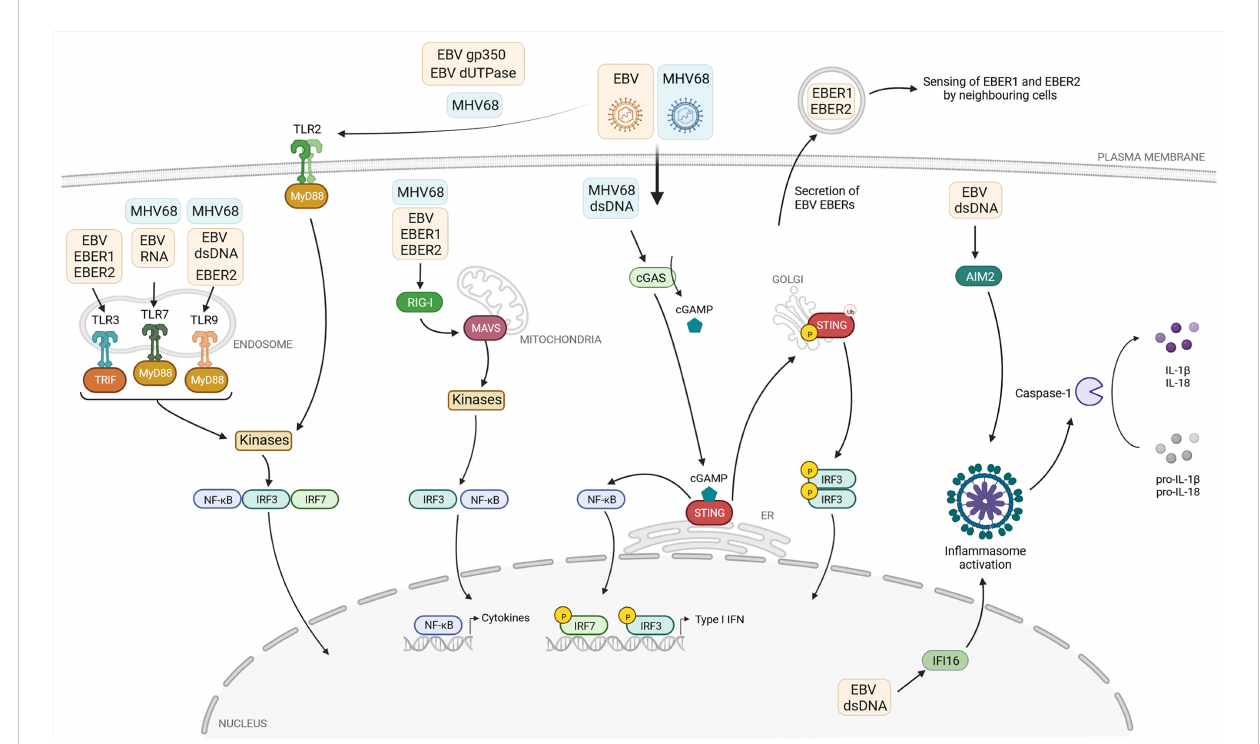
FIGURE 1 Current knowledge about the detection of the gammaherpesviruses EBV and MHV68 by pattern recognition receptors. The pattern recognition receptors (PRR) Toll-like receptors (TLR) 2, 3, 7, and 9, the cytoplasmic RNA sensor retinoic-acid-inducible protein 1 (RIG-I), and the DNA sensor cyclic GMP-AMP (cGAMP) synthase (cGAS) sense viral proteins or viral nucleic acids associated with EBV (yellow box) or MHV68 (blue box). If known, the viral ligands are depicted in the respective boxes. After binding their ligands, these PRR initiate a signaling cascade, leading to recruitment and/or activation of adaptor molecules: TIR domain-containing adaptor-inducing interferon- b (TRIF) and myeloid differentiation primary-response protein 88 (MyD88) in the case of TLRs, mitochondrial antiviral signaling protein (MAVS) for RIG-I, and stimulator of interferon genes (STING) in the case of cGAS. Subsequently, the transcription factors interferon regulatory factor 3 and 7 (IRF3, IRF7) and nuclear factor- k B (NF- k B) are activated, translocate to the nucleus and induce type I IFN and proin fl ammatory cytokine expression. The two DNA sensors absent in melanoma 2 (AIM2) and gamma- interferon-inducible protein 16 (IFI16) sense EBV-derived DNA and activate the formation of the in fl ammasome, leading to caspase-1-dependent formation of the proin fl ammatory cytokines IL-1 b and IL-18. EBER: EBV-encoded small RNA. Created with